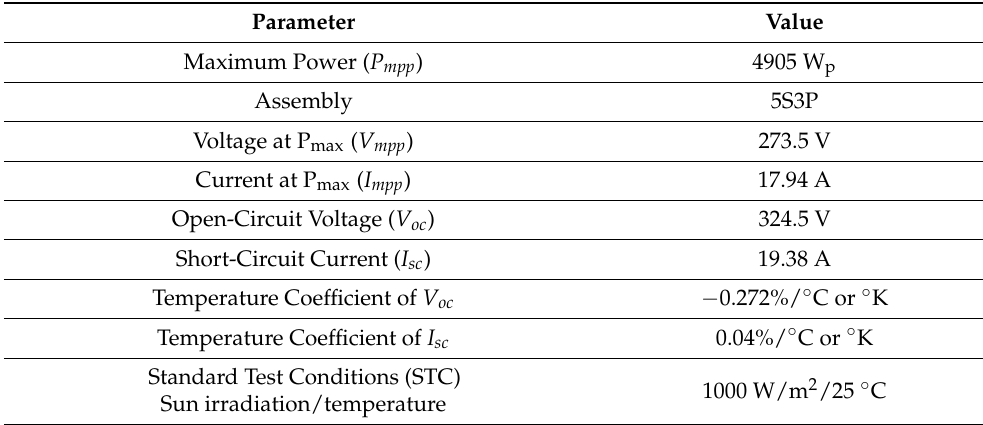
Table 1. The PV system